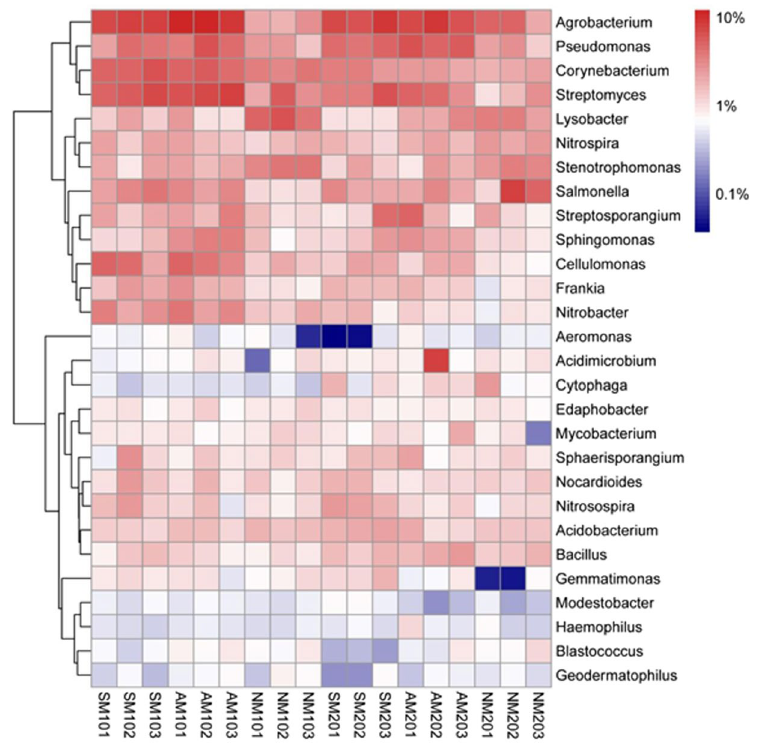
Figure 4. Heat map showing the abundance of bacterial genera in each sample (the genera with an average abundance greater than 0.5% in one group were defined as abundant). The colour intensity (log scale) in each panel shows the percentage of a genus in a sample; please refer to the colour key at the right